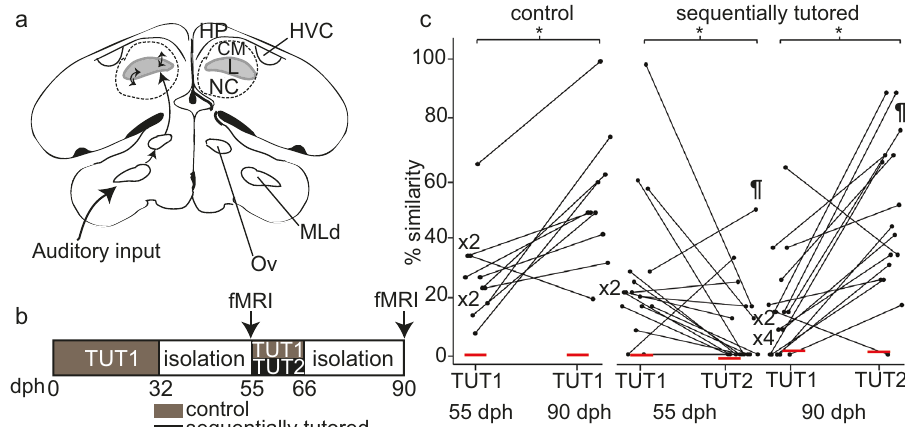
Fig. 1 Anatomy of the avian brain, experimental timeline, and song learning in control and sequentially tutored birds. a Schematic showing the avian auditory pathway in coronal plane. Pathway indicated in the left hemisphere, with identical regions labeled in the right hemisphere. Line drawings of a coronal section adapted from the zebra fi nch stereotaxic atlas 89 . MLd: dorsal lateral nucleus of the mesencephalon lateralis dorsalis, NC: caudal nidopallium (includes both the caudomedial nidopallium [NCM] and the caudolateral nidopallium [NCL]), CM: caudal mesopallium (includes the caudomedial mesopallium [CMM]), HP: hippocampus, Ov: nucleus ovoidalis, L: fi eld L. b Experimental timeline. Juvenile male zebra fi nches were housed with their fi rst tutor (TUT1) until 32 dph and then individually isolated in acoustic chambers. From 55 – 66 dph, juveniles were either housed together with their TUT1 (control) or a novel tutor (TUT2), and subsequently isolated and sacri fi ced at 150 dph. Two fMRI sessions were performed: at 55 dph and at 90 dph (black arrows). c Zebra fi nches can learn to imitate songs from two tutors sequentially. % Similarity is expressed as the percentage of shared elements between the tutee ’ s song and the tutor ’ s song. * indicates signi fi cant differences ( P < 0.05) in similarity scores for 55 vs. 90 dph in control birds (left, N = 10), and for TUT1 vs TUT2 in 55 dph (center) and 90 dph (right) sequentially tutored birds ( N = 16). ¶ indicates a signi fi cant increase ( P < 0.05) in similarity scores with the second tutor between 55 dph and 90 dph. Each dot and line represent an individual bird. Red horizontal lines indicate mean similarity with an entirely different set of unfamiliar songs (different from those used as second tutors, which are also novel at 55